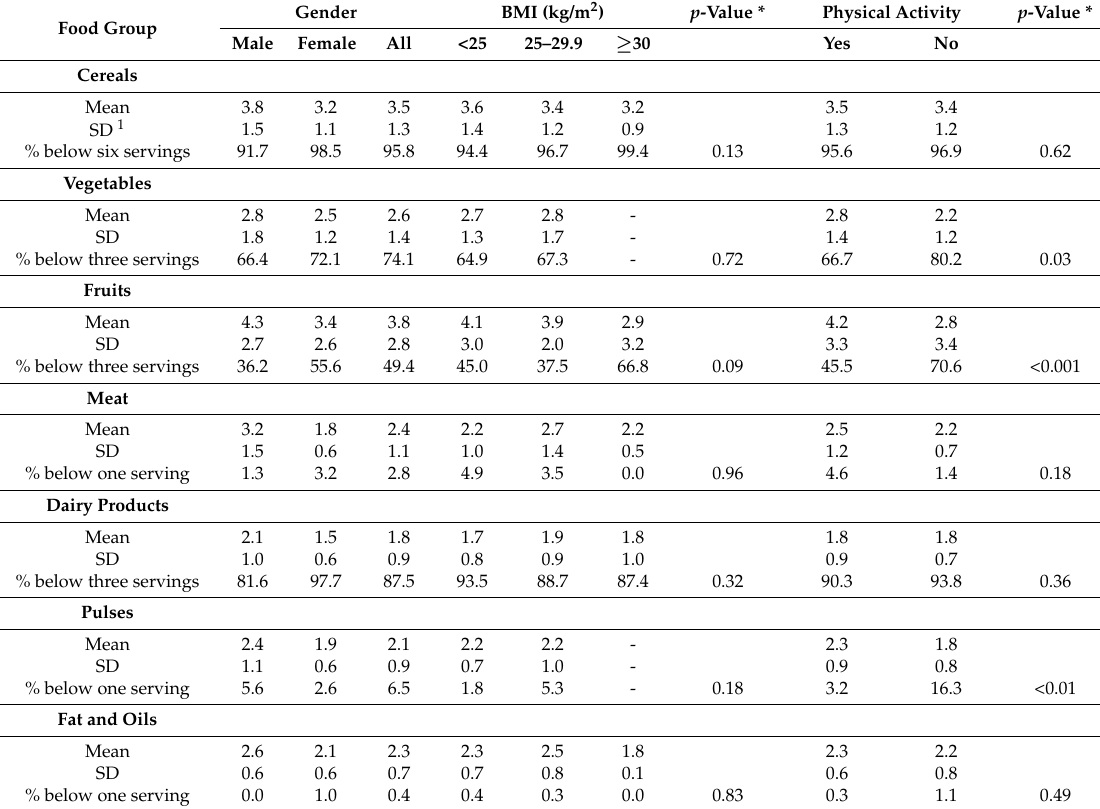
Table 3. Usual intake of food groups according to the number of servings recommended by the 2006 Brazilian National Dietary